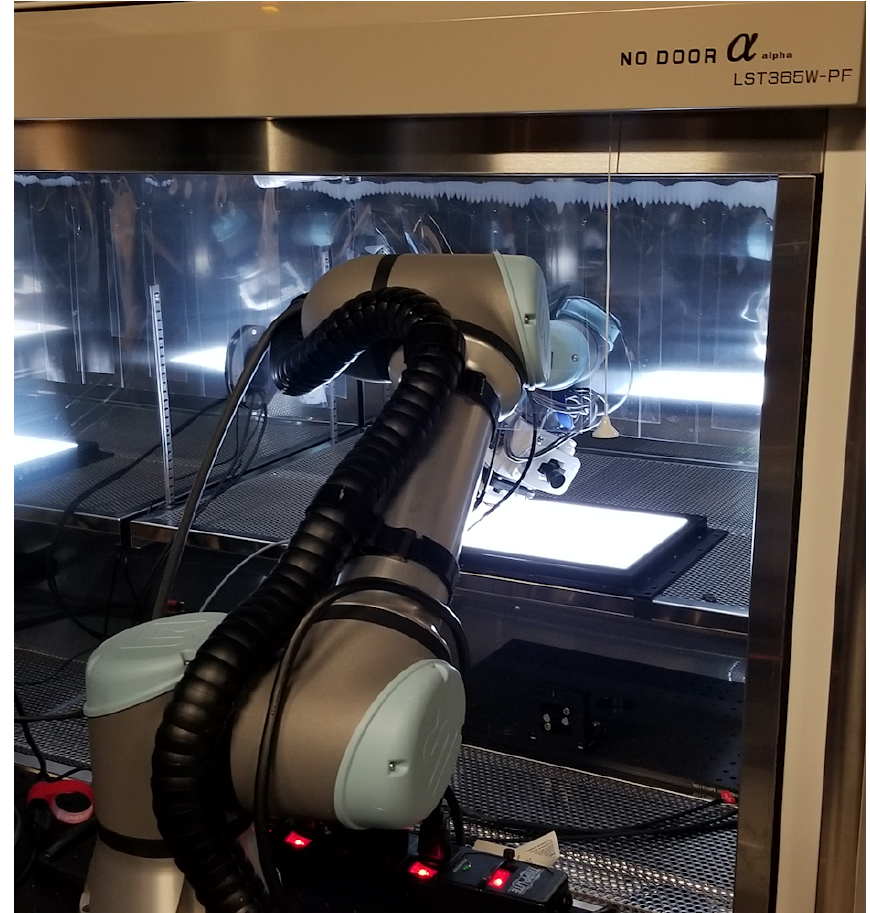
Figure 5. Sensor assembly on robot arm in temperature